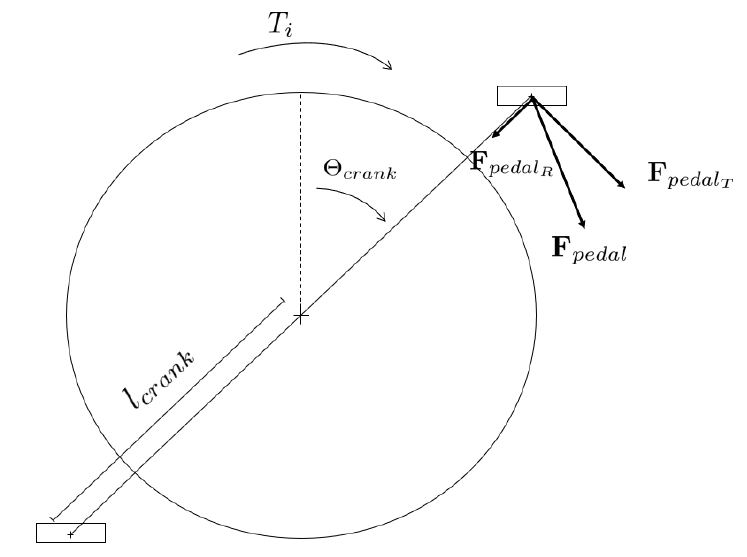
Figure 3. Pedalling torque generated by an applied pedalling force in a generic